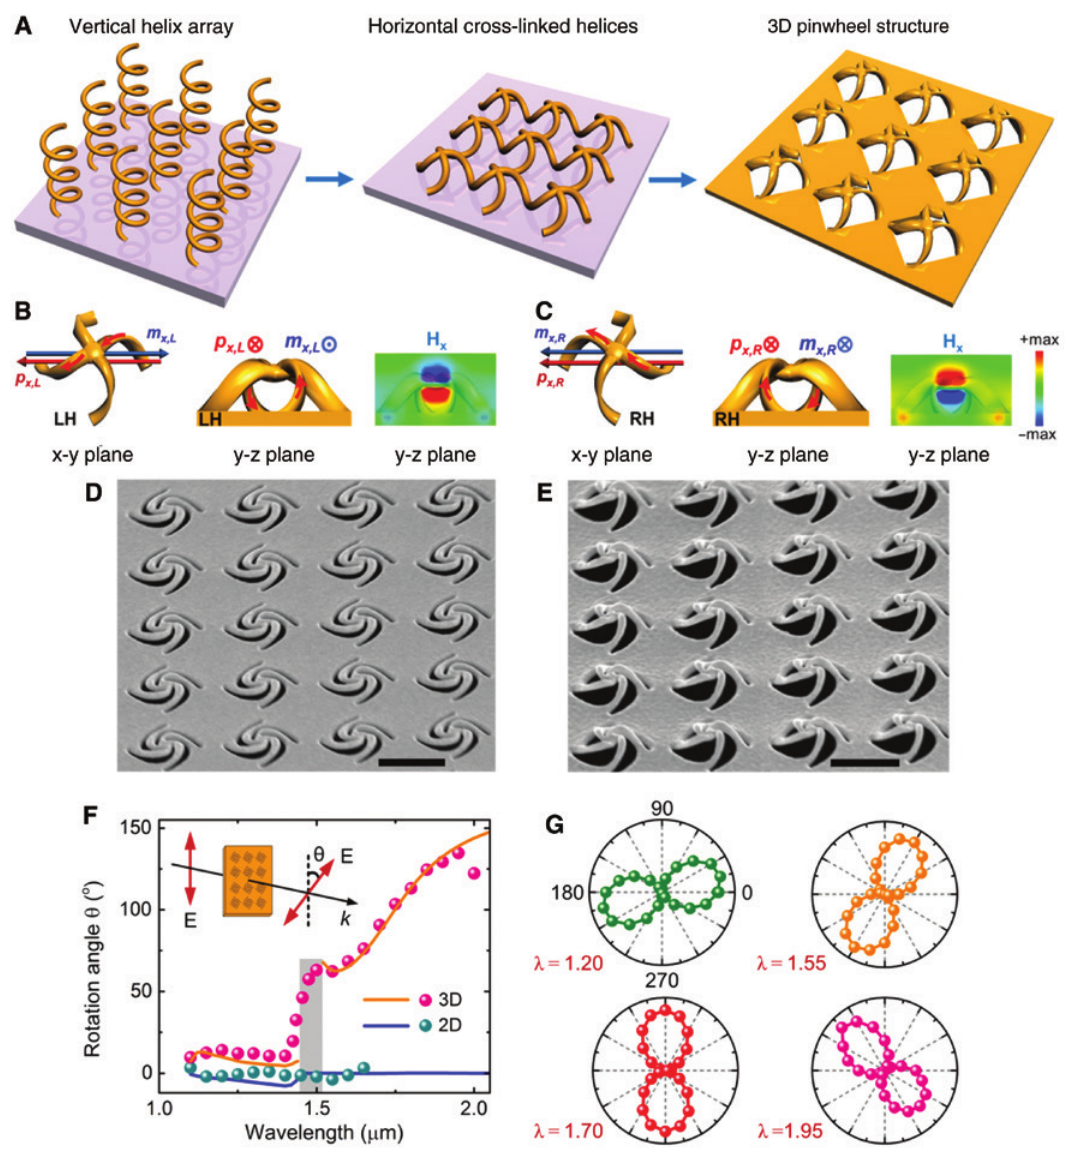
Figure 9: Giant 3D optical chirality enabled by close-loop nano-kirigami [39]. (A) Schematic of a vertical helix array, horizontal cross-linked helices, and a 3D pinwheel array, which show the evolution of the designed pinwheel structure. (B, C) Illustration of the responses to the electric field ( E ) of incident light for the left-handed (LH) and right-handed (RH) x twisted pinwheels in (left) x–y plane and (middle) y–z plane, respectively. (right) Calculated magnetic field ( H ) at the wavelength 1.7 μ m x in the y–z plane ( x = 0) under x -polarized excitation. The direction of H at center part of the pinwheels agrees well with the illustration. x (D, E) SEM images of left-handed (LH) pinwheel arrays (D) before and (E) after global FIB irradiation, respectively. Scale bars: 1 μ m. (F) Measured (circular points) and calculated (solid lines) linear polarization rotation angle ( θ ) versus wavelength for 3D and 2D LH pinwheels, respectively. (Inset) Schematic of the linear polarization rotation. (G) Polar plots of experimental transmission versus detection polarization angle at specific wavelengths as noted for the 3D LH